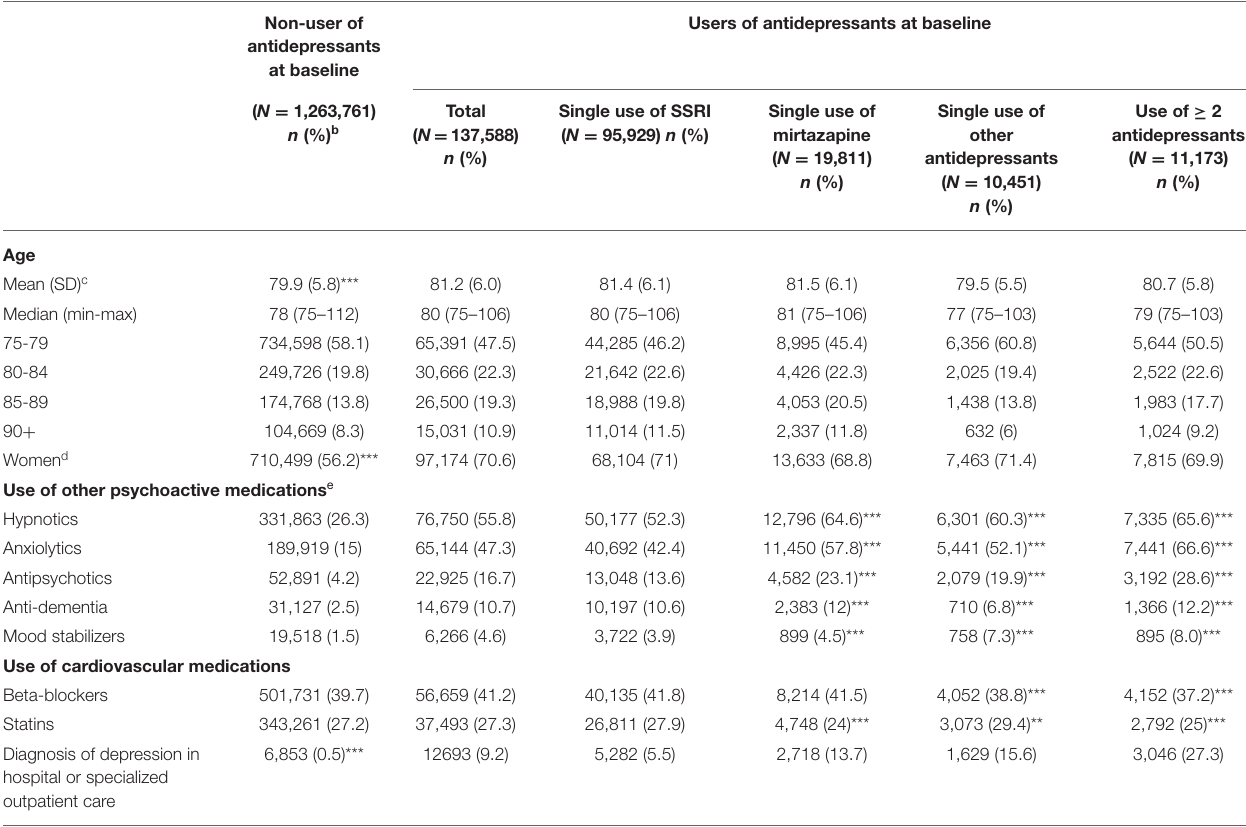
TABLE 1 | Baseline characteristics of persons aged 75 and above residing in Sweden between 2007 and 2014 a ( N = 1,401,349). Non-user of